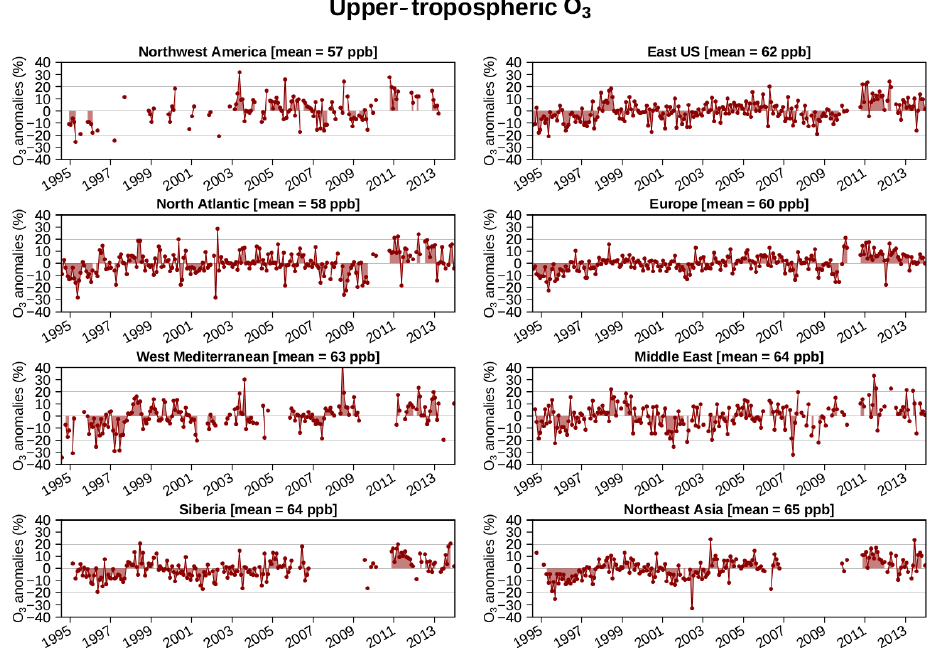
Figure C1. Relative monthly anomalies of O 3 volume mixing ratio in the upper troposphere. The units % refer to the corresponding clima- tological means indicated above each graph.